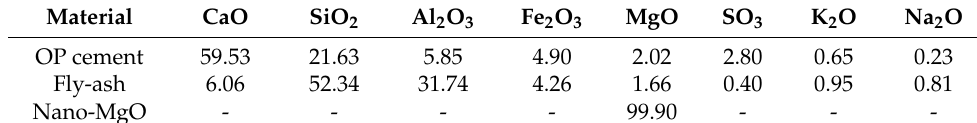
Table 1. Chemical compositions (wt%) of ordinary Portland cement, fly-ash, and nano-MgO. Material